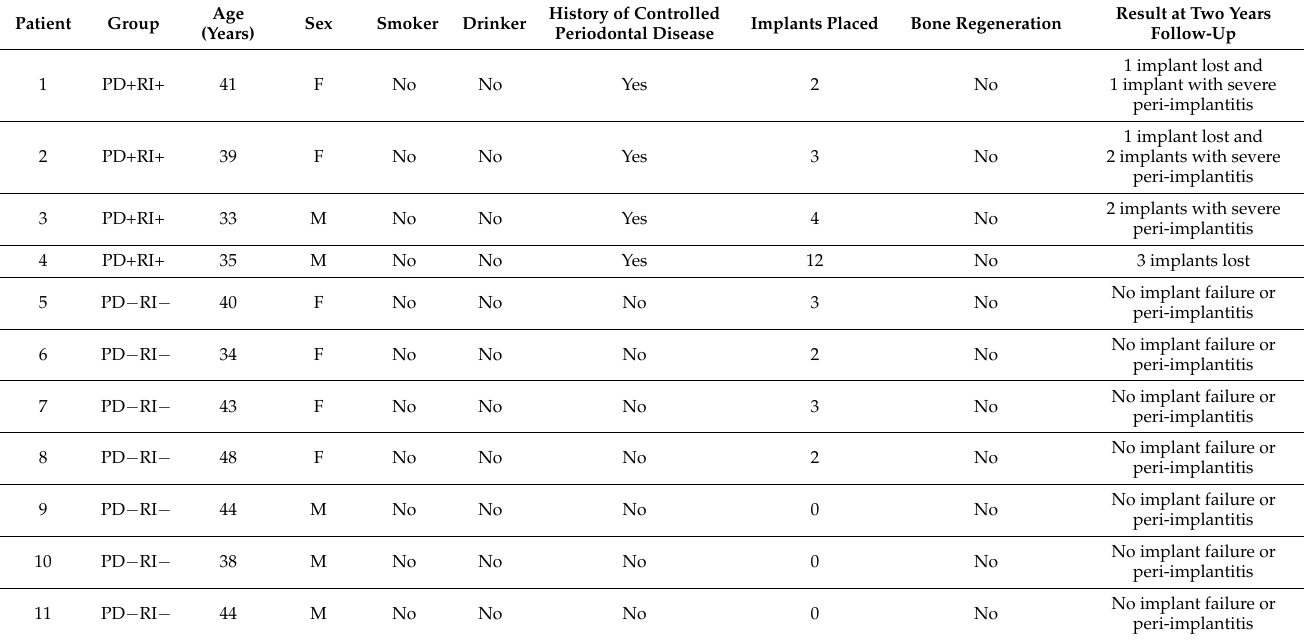
Table 3. Clinical data of the patients included in the study. To increase the number of patients in the control group, we included Patients 9, 10, and 11, who did not yet have implants in place. However, these patients did not have periodontal disease and would therefore not be candidates for early failure after implant